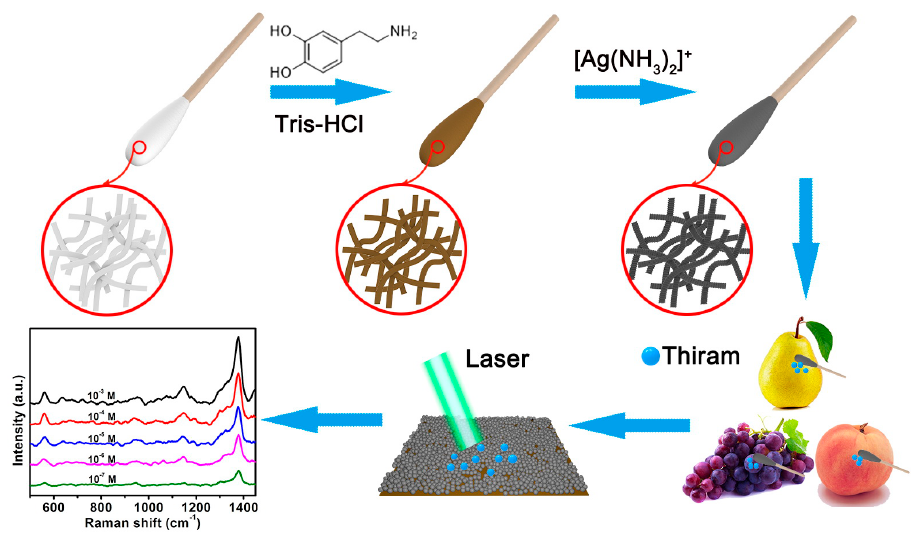
Figure 1. The schematic of the fabrication of CS@PDA@AgNPs swabs for the conformal rapid SERS detection of thiram bactericide residues.